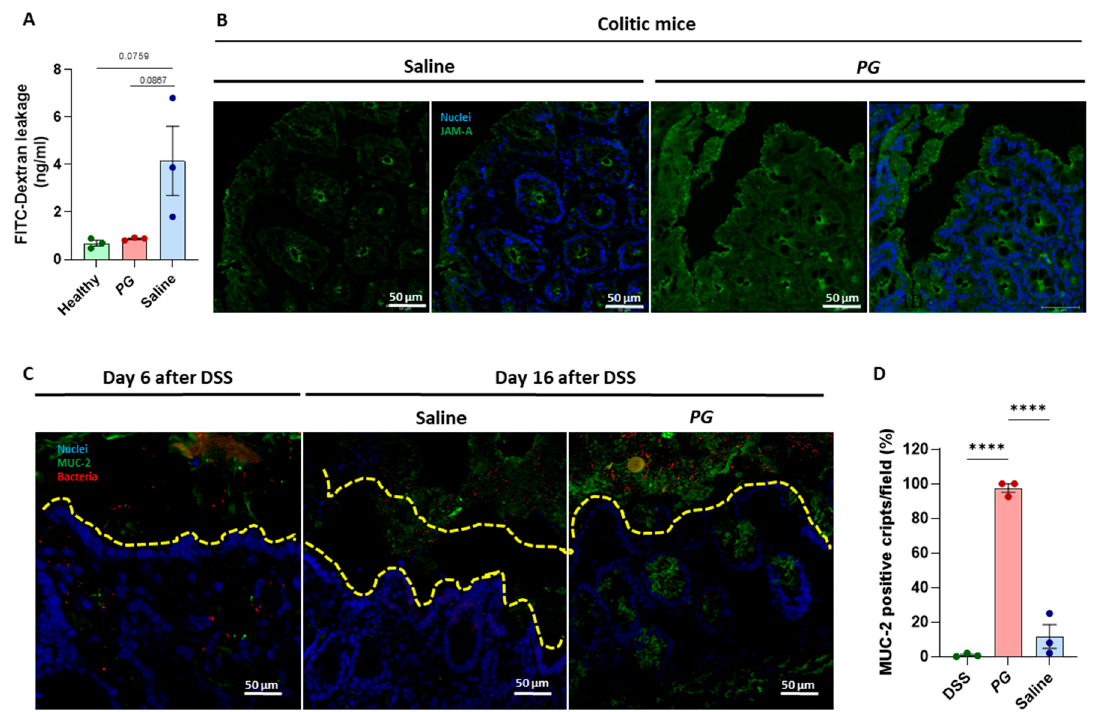
Figure 2. PG restored the intestinal barrier in vivo with the formation of a mucus layer. ( A ) Intestinal permeability was evaluated through FITC-dextran assay in healthy and PG or saline-treated mice, quantifying FITC-dextran levels in murine sera. ( B ) Representative images of immunofluorescence staining of JAM-A (green) in the epithelial layer and crypts of colitic mice during the recovery phase subjected to saline or PG . ( C ) Fluorescence in situ hybridization for bacterial rRNA (red) and immunofluorescence staining of MUC-2 (green); and (D) quantification of MUC-2 positive cripts for field (40X)was performed in the colonic mucosa of colitic mice before and after the recovery phase with the administration of saline or PG . (DAPI = nuclei in blue. Scale bar = 50 μ m. Data are presented as mean ± SEM. One-way ANOVA test. **** p < 0.0001. n = 3 mice/group.